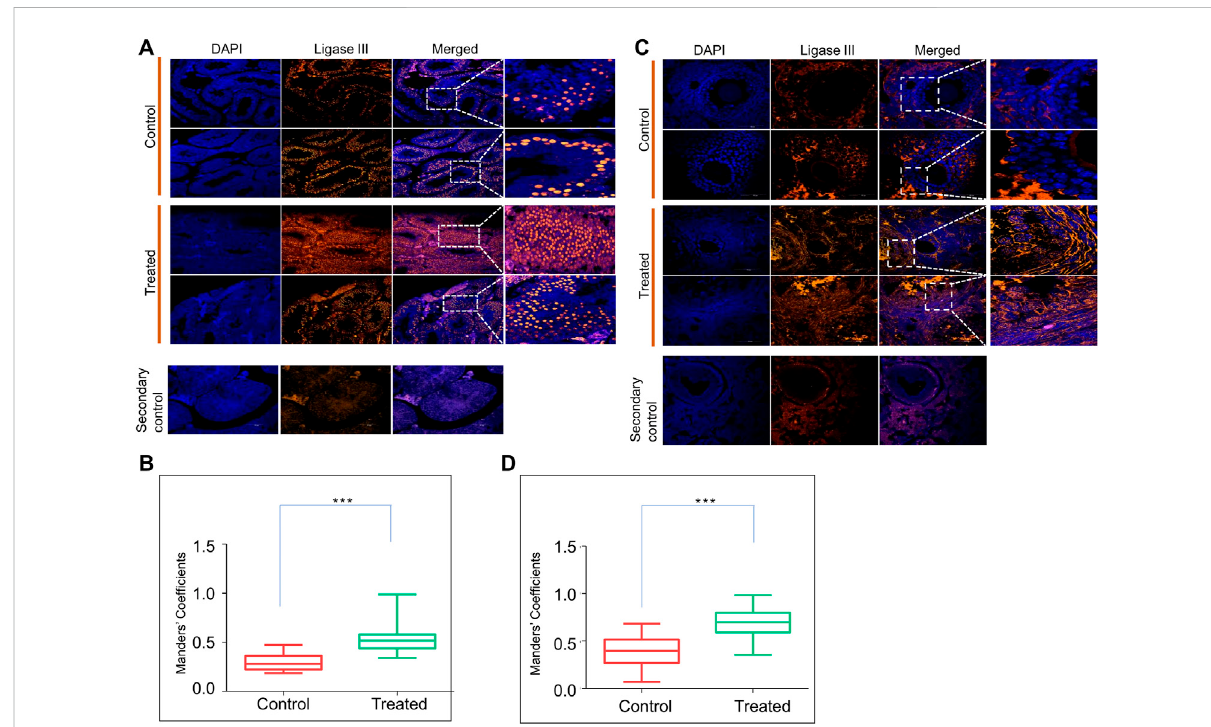
FIGURE 6 EvaluationofESinducedDNArepairthroughLigaseIIIinreproductiveorgans. (A) Immuno fl uorescenceofDNALigaseIIIexpressionintestesof ES-treatedmice(5 mg/kg,10doses, n =2).Tissuesampleswerecollectedafter8 monthsofexposuretoES.Controlindicatessectionsoftestesfrom untreated mice, whereas, ES is sections from treated mice. The nucleus is counterstained with DAPI. The merged image shows localisation of DNA Ligase III positive cells. (B) Bar graph shows localization of DNA Ligase III positive cells in control and treated mice testis calculated as Mander ’ s coef fi cient on ImageJ. (C) Evaluation of ES induced DNA Ligase III in mice ovary. Immuno fl uorescence staining of DNA Ligase III expression in ovary of control and ES treated mice. (D) Bar graph indicates localization of DNA Ligase III positive cells in control and treated mice ovary calculated as Mander ’ s coef fi cient on ImageJ. In panels (B,D) at least 20 fi elds each were analyzed from two independent batches (ns: not signi fi cant, * p < 0.05, ** p < 0.005, *** p <